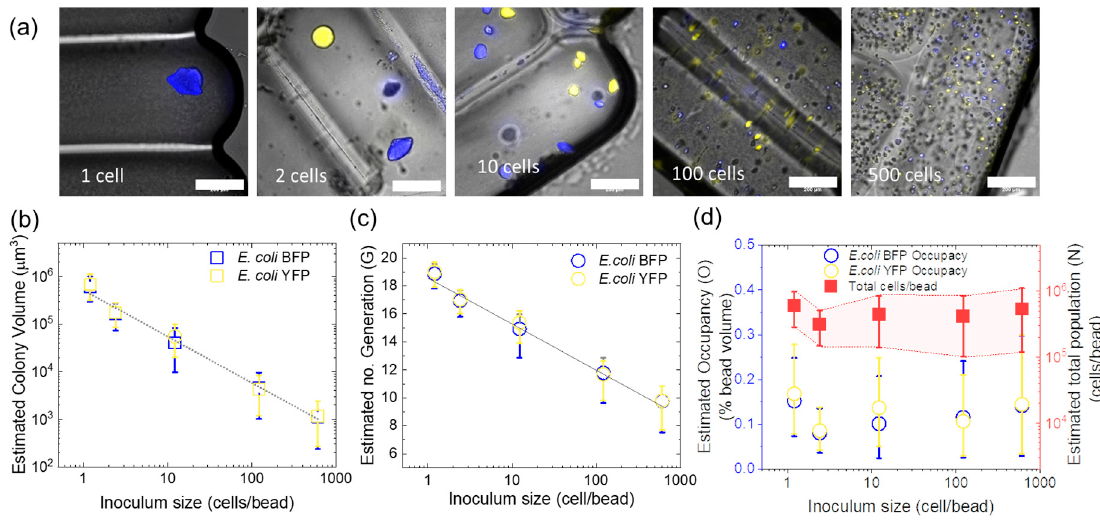
Figure 3. Effect of inoculum size on the final colony size of E. coli YFP and E. coli BFP in agarose microbeads after 24 h of incubation. ( a ) Overlap microscopic images of bacterial colonies in mi- crobeads at different initial inoculation densities. Scale bar: 200 μ m. ( b ) Relationship between estimated bacterial colony volume and inoculum size. ( c ) Relationship between the estimated number of bacterial generations produced in a single colony and inoculum size. ( d ) Volume occupancy of bacterial colonies in the microbead (left axis, yellow and blue circles) and total cell population (right axis, red squares) at different inoculum sizes. Error bars represent errors calculated from the standard deviation of the measured area of at least 59 sample colonies.